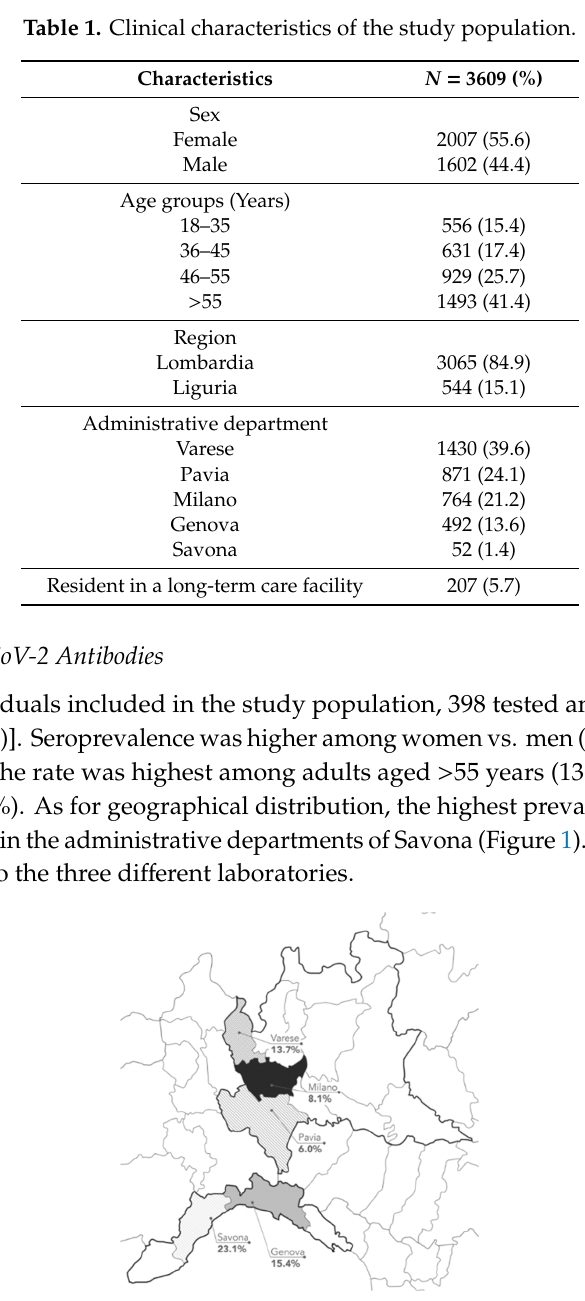
Figure 1. Serologically-confirmed cases of SARS-CoV-2 in the general Italian population from 1 March to 30 April 2020. Red and blue lines represent the boarders of the Lombardia and Liguria regions, respectively. Percentages show the number of positive samples per number tested in each administrative department.